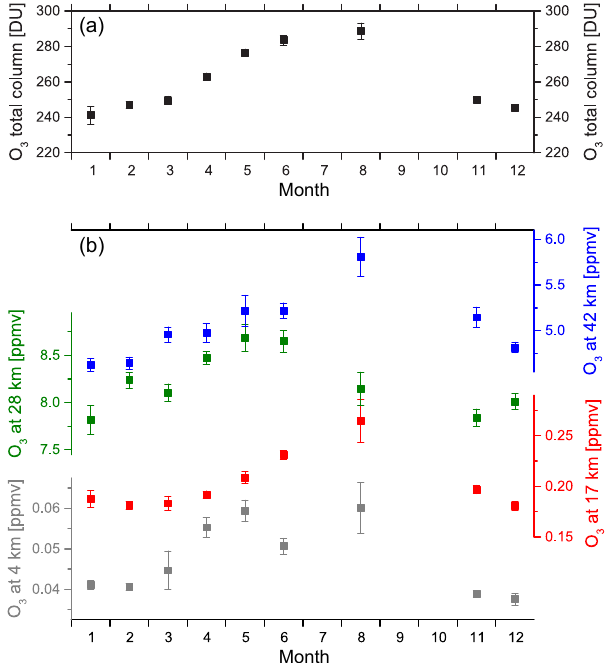
Figure 6. Seasonal O 3 cycles as obtained from the Altzomoni FTIR measurements. Means are shown for all the months with measure- ments for at least three different days. (a) For the total column amounts. (b) For the altitudes that are highlighted in the kernel plot of Fig. 3a. Please note that for November–February the monthly means are calculated with data from two different years (2012/13 and 2013/14) for the other months the monthly means are calcu- lated from data of 2013